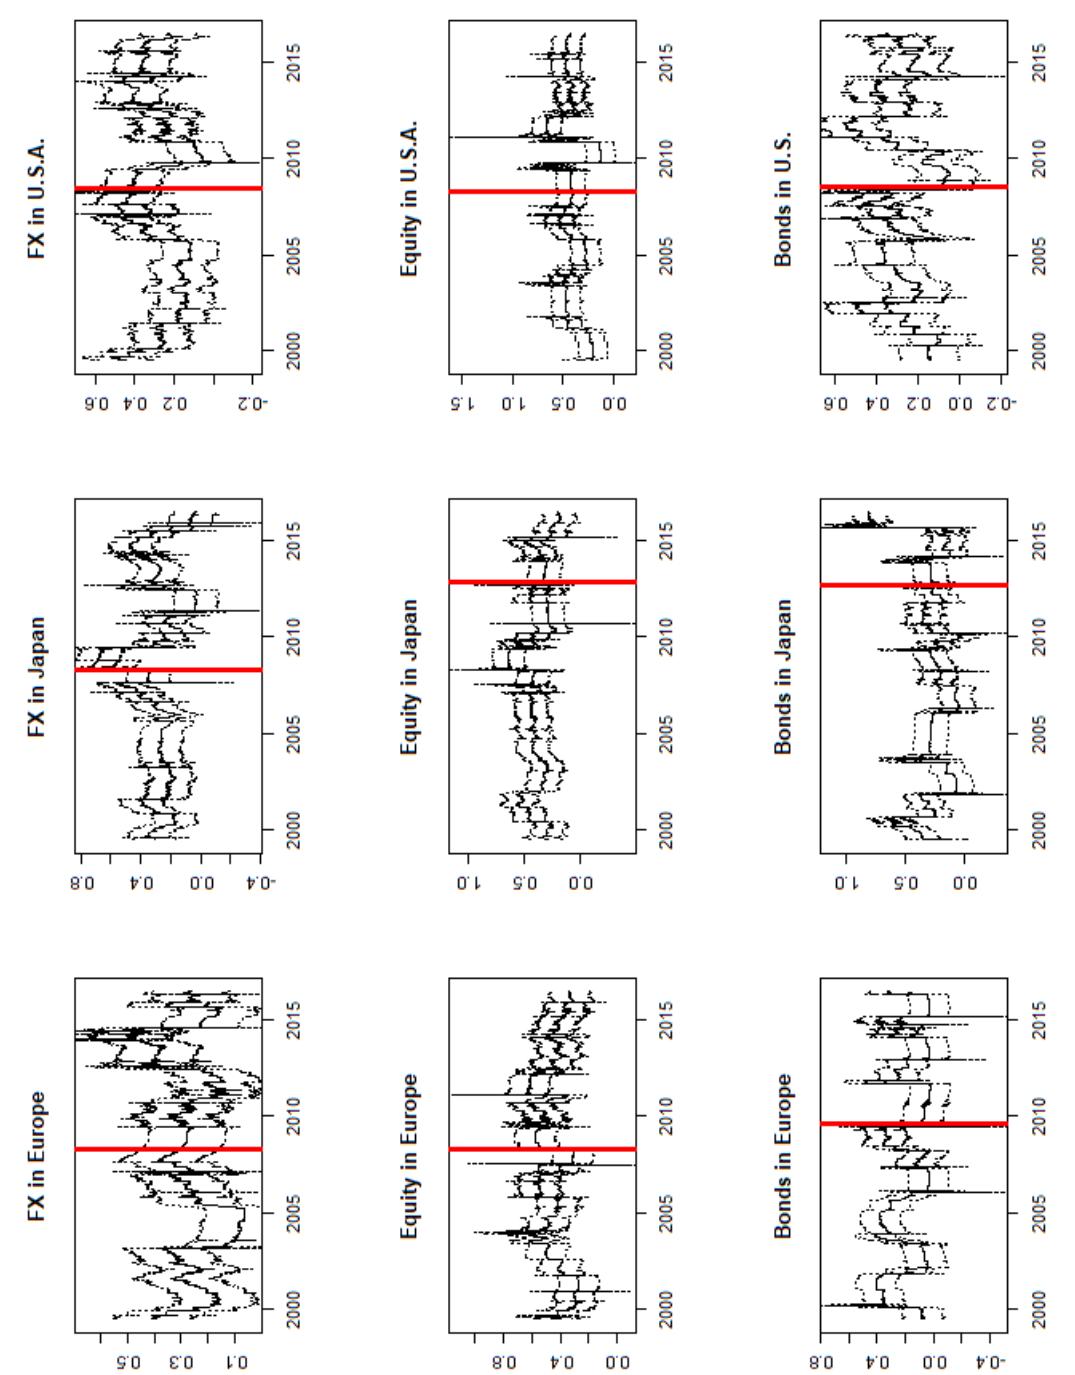
Figure 2. Rolling window estimates for foreign exchange, equity and bond markets in Japan, Europe and U.S. Bold vertical line corresponds to the estimated